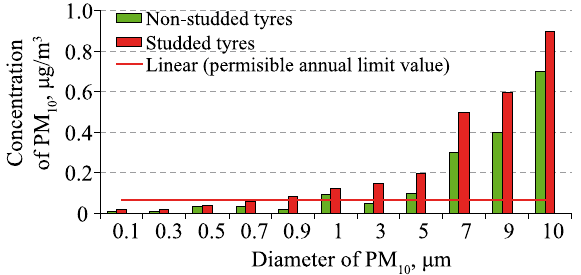
Fig. 4. Dependency ofPM 10 emission concentration on particle diameter, when a passenger car travels at a speed of 15 km/h by Ketzel et al.